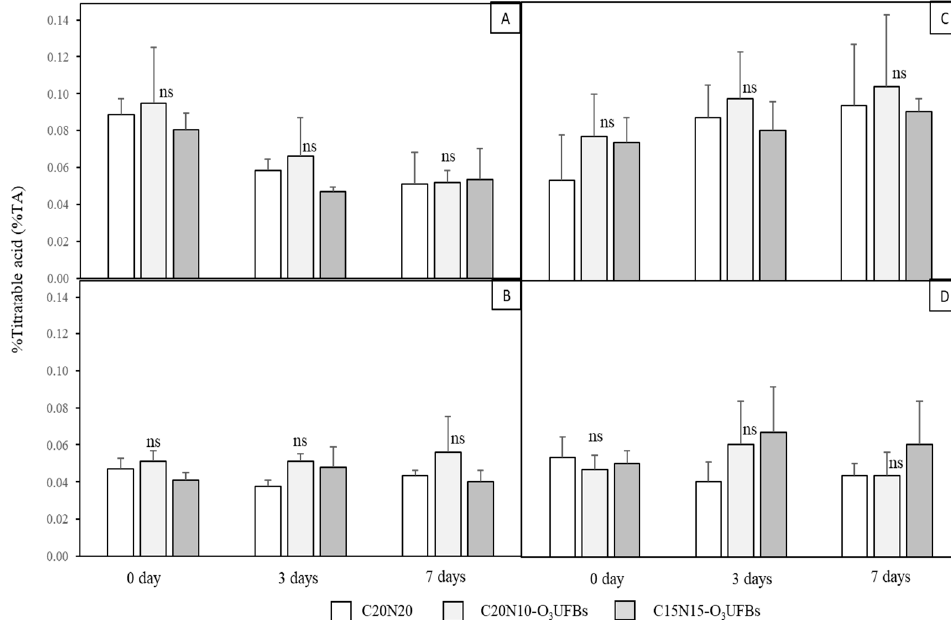
Figure 8. Titratable acidity (TA) of coconut water ( A , B ) and coconut meat ( C , D ) for trimmed coconuts dipped in C 20 N 10 -O 3 UFBs and C 15 N 15 -O 3 UFBs compared with C 20 N 20 when stored at 2 °C for 0 days (before storage) ( A ) and 30 days ( B ). After storage, all coconut fruits were transferred to 8–10 °C for 7 days and TA was evaluated on days 0, 3, and 7. ns: not significantly different.